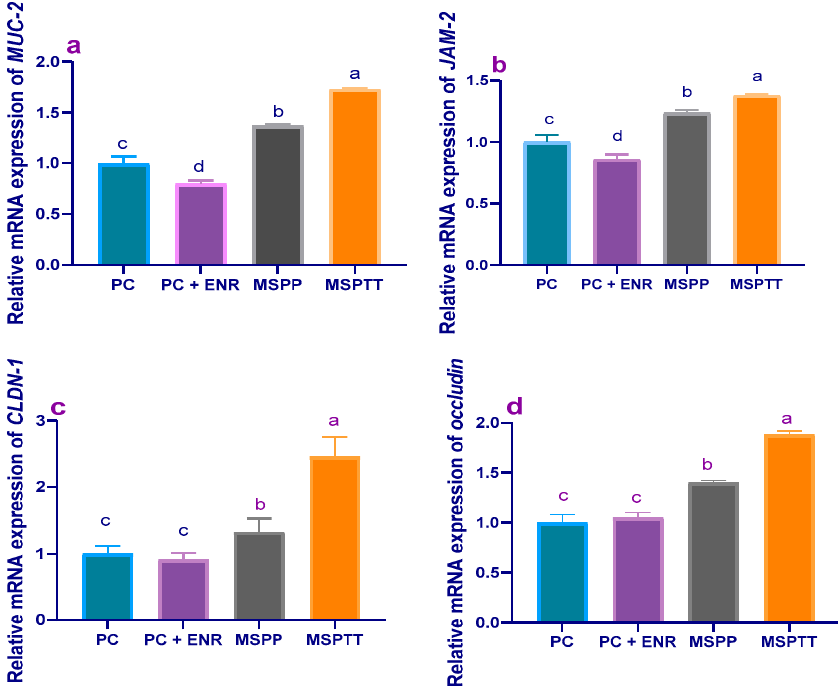
Figure 3. Levels of mucin-2 ( MUC-2 , ( a )), junctional adhesion molecule-2 ( JAM-2 , ( b )), claudins-1 ( CLDN-1 , ( c )), and occludin ( d ) mRNA expression in rabbits fed different levels of multi-strain probiotics at the end of the growing period (60 d of age). MSP: multi-strain probiotics including Lactobacillus acidophilus NBIMCC 8242, Bacillus subtilis DSM 17,299, and Enterococcus faecium NBIMCC 8270. Control: rabbits fed a basal diet; MSPI, II and III: rabbits fed a basal diet supplemented with MSP at the levels of 1 × 10 6 , 1 × 10 7 , and 1 × 10 8 CFU/kg, respectively. Values are means with their SE in bars. a–d : Means inside the same column having various superscripts are significantly different at p < 0.05.